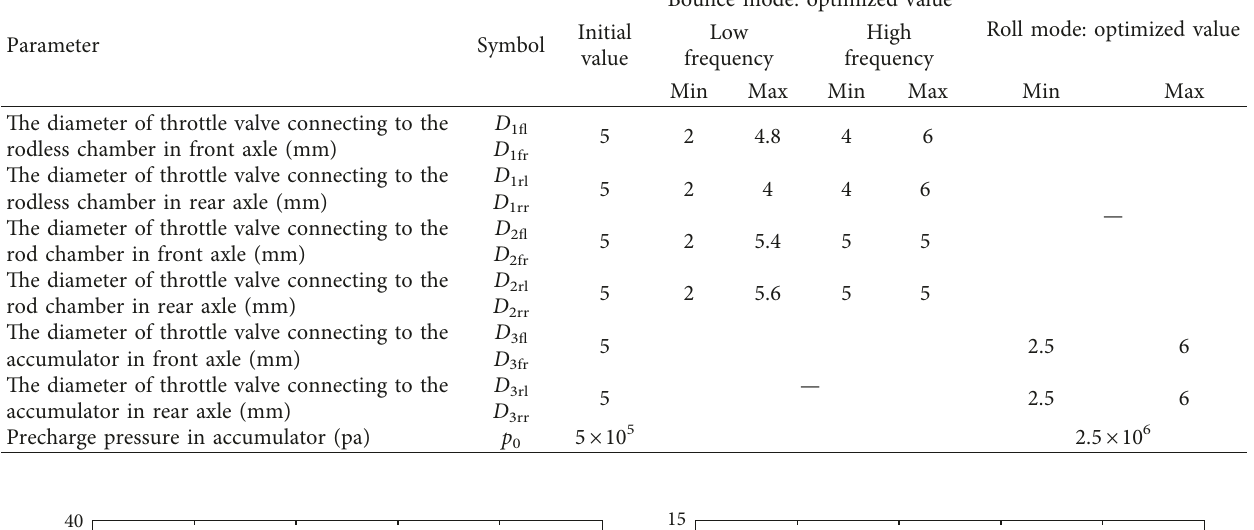
Table 5: Optimized results.